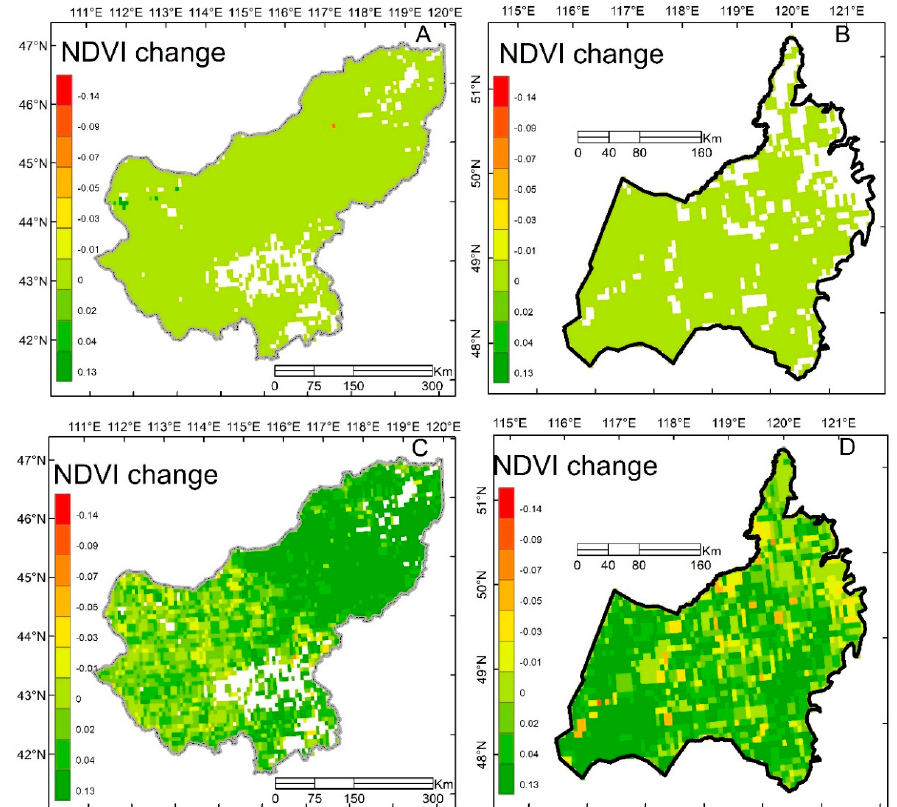
Figure 7. NDVI change di ff erence between di ff erent methods in Xilingol and Hulunbuir. ( A , B ) The results of TSS-RESTREND minus RESTREND trend which indicates e ff ects on break year detection on NDVI time series; ( C , D ) the results of TSS-RESTREND minus NDVImax trend which indicates to what extent of NDVImax trend is attributed to rainfall